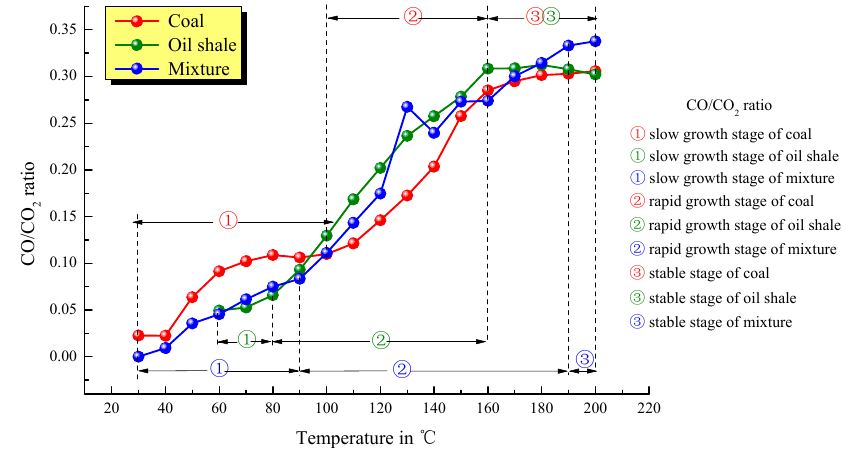
Figure 4. Relationship between the CO/CO 2 ratio and temperature for the experimental samples.